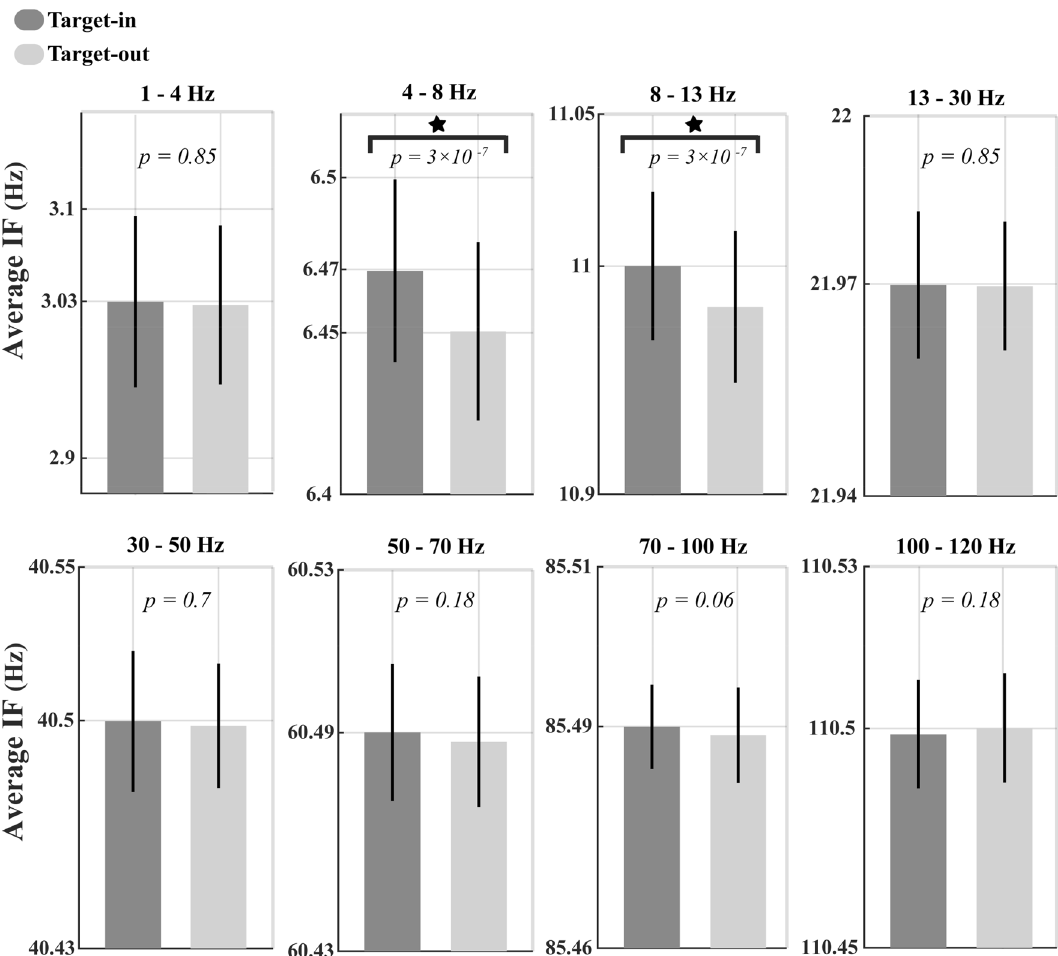
Figure 2. Frequency specificity of MT neurons in processing goal-oriented stimuli. The light and dark bars represent the average instantaneous frequency of neurons in Delta (1–4 Hz), Theta (4–8 Hz), Alpha (8–13 Hz), Beta (13–30 Hz), low-Gamma (30–50 Hz), mid-Gamma (50–70) and high-Gamma (70–120) bands at the target-in and the target-out conditions, respectively. Error bars represent the ± 1 STD. The inset p -values depict the significance level of differences between the target-in and the target-out conditions for each frequency band (two-sided sign-test). Asterisks indicate frequency bands with a significant difference in the average instantaneous frequency of neurons between the two target conditions ( p < 10 −6 , two-sided